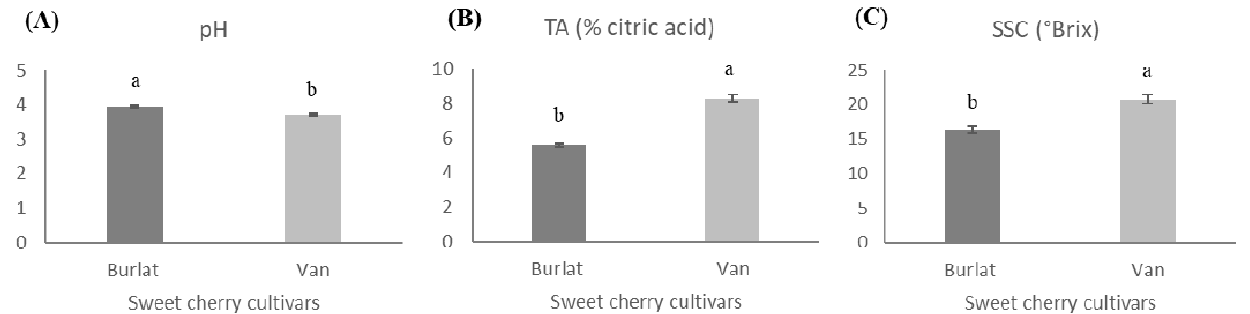
Figure 2. Sweetness and acidity of the two sweet cherry cultivars (Van and Burlat): ( A ) pH; ( B ) Titratable acidity (TA); ( C ) Total soluble solids content (SSC) of the two sweet cherry cultivars. The presented values resulted from the mean ± SD ( n = 3). Statistically significant differences between cultivars, for each parameter, were represented by different letters (ANOVA-Tukey’s test, p < 0.05).